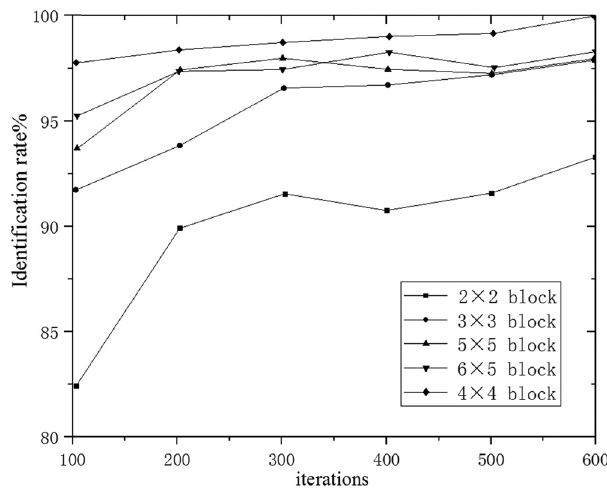
Figure 2: The recognition rate of the uni fi ed mode LBP operator of di ff erent